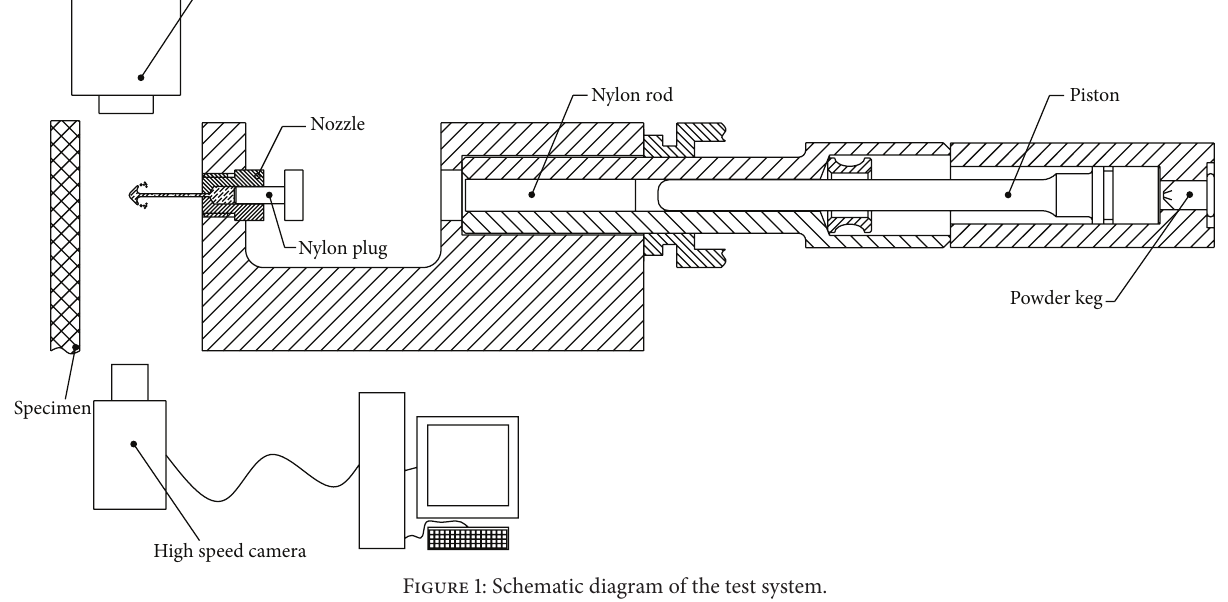
Figure 1: Schematic diagram of the test system.